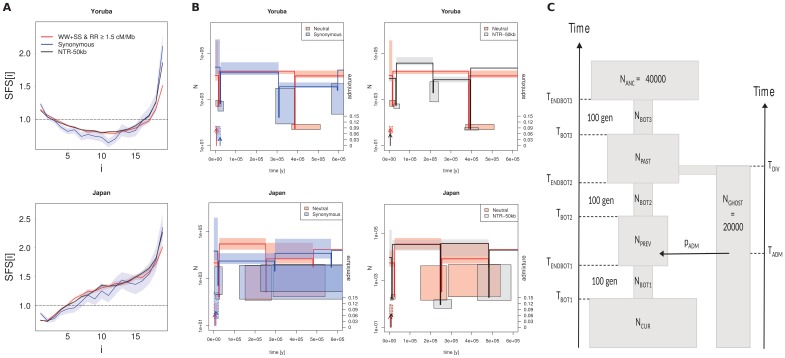
Recent demography inferred from three different datasets in the Yoruba and Japan 1000G populations.(A) Observed SFS computed on the three datasets. Neutral: neutral SFS computed on WW +SS sites in regions with recombination rate (RR) ≥1.5 cM/Mb; Synonymous: synonymous SFS; NTR-50kb: SFS computed on sites in non-transcribed regions more than 50 kb away from any transcribed region. Synonymous and NTR-50kb SFS are significantly different from neutral SFS with p-values<10−3. (B) Comparison of inferred demographic events in the last 600,000 years under the model shown in panel C. Left and right panels compare neutral estimations to those of different datasets. All parameter values are given in Supplementary file 3 - Table S3. Solid lines represent maximum-likelihood (ML) estimates of population sizes and bottleneck times. Vertical arrows indicate ML estimates of admixture times; their height is proportional to the admixture estimates shown on the right axis. Boxes delimit 99% confidence intervals obtained by a block-bootstrap approach (see Materials and methods). Boxes surrounded by a solid line are for bottleneck parameters (size and time), open boxes are for population size between bottleneck events, and boxes surrounded by a dashed line are for admixture rates and times. Note that bottlenecks have been modeled with a fixed duration of 100 generations, and the width of the boxes denotes the range covered by 99% of the bootstrap estimations. (C) Sketch of the demographic model used for SFS-based demographic inferences. The model includes three possible bottlenecks of a fixed duration of 100 generations in the direct ancestry of the sampled population, and it allows some sampled genes (a fraction pADM) to have ancestors coming from an unsampled (ghost) population at any time (TADM) since its divergence from the sampled population TDIV generations ago. Note that in this model, NANC and NGHOST have been arbitrarily fixed to 40,000 and 20,000 (haploid sizes), respectively. Note also that the ghost population is used here to allow for some gene flow from some unspecified source, and so to account for the non-isolated nature of human populations.